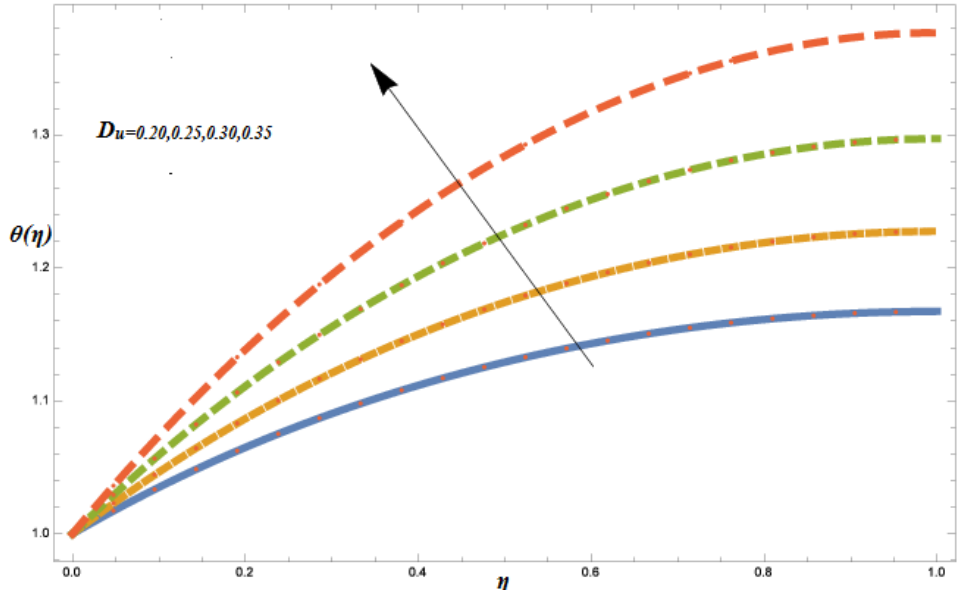
Figure 13. Variations in velocity field f ( η ) for various values of D u , when (cid:125) = − 0.25, P r = 10, S c = 0.7, λ = 0.7, Λ = 0.7, β = 1, S = 0.7 .